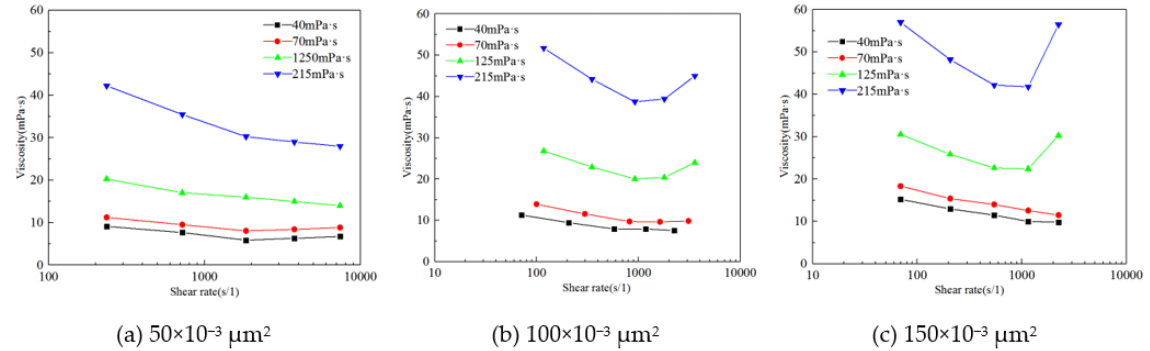
Figure 7. Core viscosity changes at different permeabilities. ( a ) 50 × 10 -3 μ m 2 . ( b ) 1.00 × 10 -3 μ m 2 . ( c ) 1.50 × 10 -3 μ m 2 . ( c ) 1.50 × 10 − 3 µ m 2